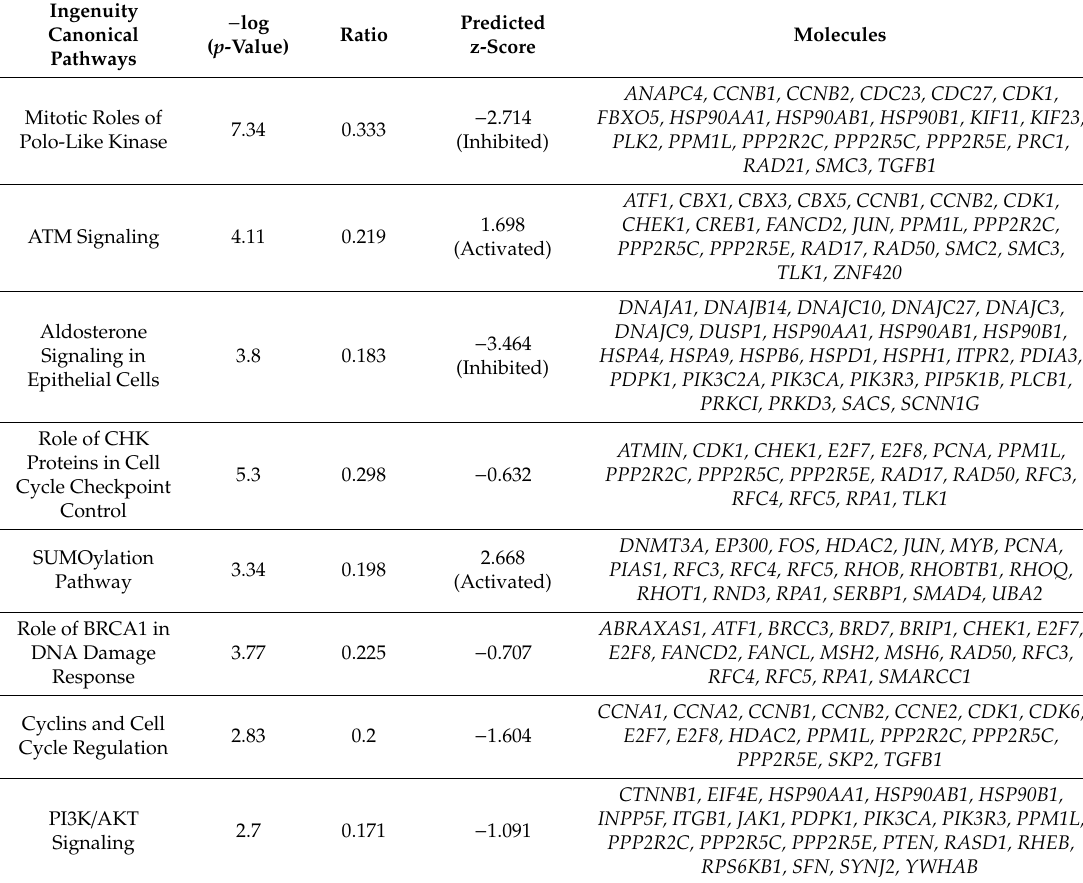
Figure 3. Significant pathways identified by IPA. The top 11 altered canonical pathways predicted from DEGs of endometriosis. Negative and positive z-scores, colored in shades of blue and red, represent inhibition and activation of pathways, respectively. Table 4. Significant canonical pathways based on DEGs of endometriosis. Positive and negative z- scores indicate overall activation and inhibition status of pathways, respectively.